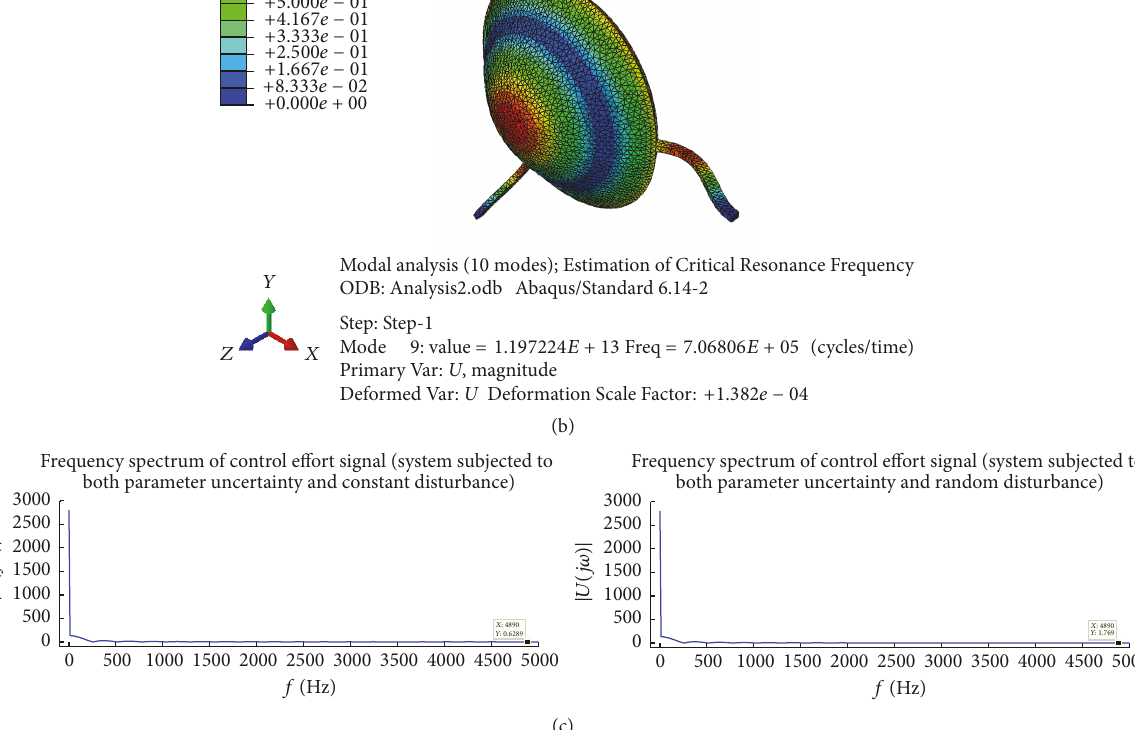
Figure 8: Mechanical analysis: ((a) and (b)) deformation of top plate and its displacement in modal analysis carried out in 10 modes; deformation in mode 1 and in mode 9; (c) spectrum of control effort signal in the adaptive sliding mode